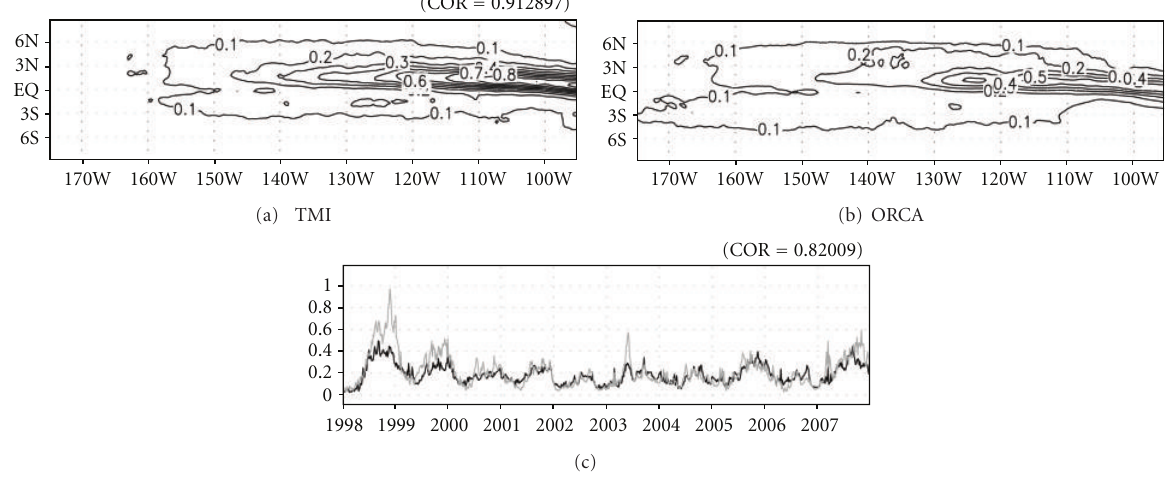
Figure 1: Temporal variance of SST from (a) TMI and (b) ORCA model data for ten years, and (c) time-varying spatial variance over 160–90 ◦ W, 4 ◦ S-4 ◦ N for the TMI (black curve) and ORCA model (gray curve).